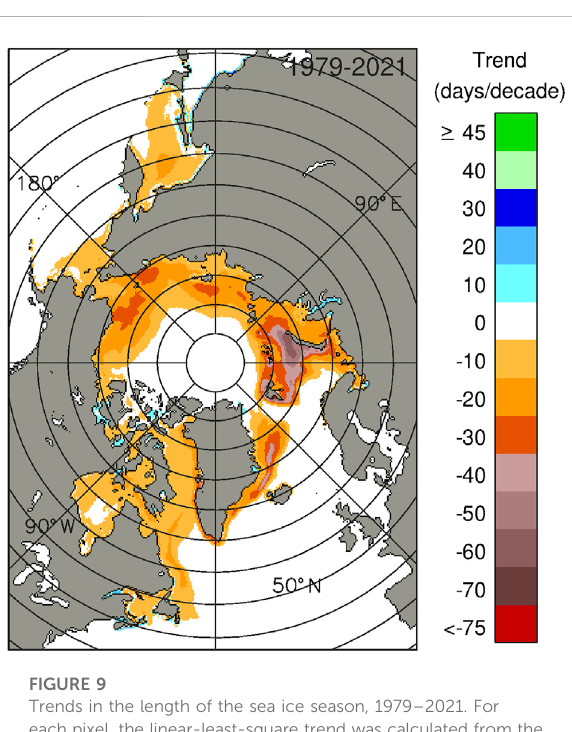
FIGURE 9 Trends in the length of the sea ice season, 1979 – 2021. For each pixel, the linear-least-square trend was calculated from the 43 yearly values of the length of the sea ice season at that pixel.